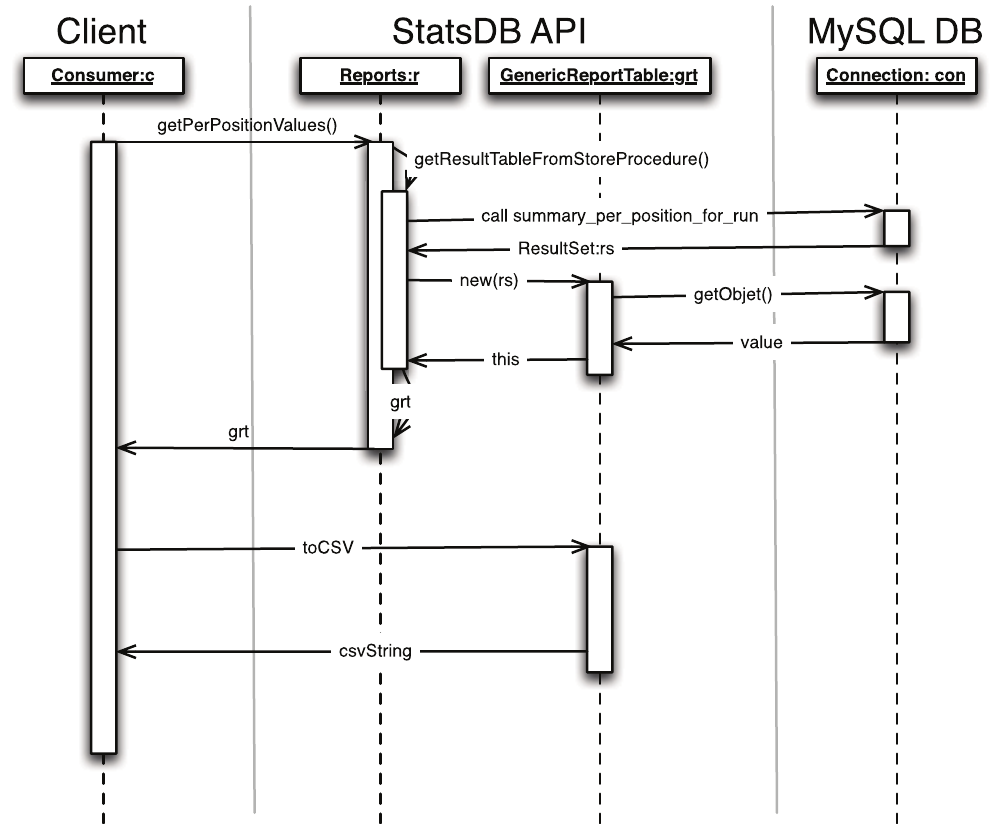
Figure 4. Example of the execution of a query to the database. The client only needs to be aware of the Java/Perl API and StatsDB will format the result in CSV or JSON, so that the client can display the summary.